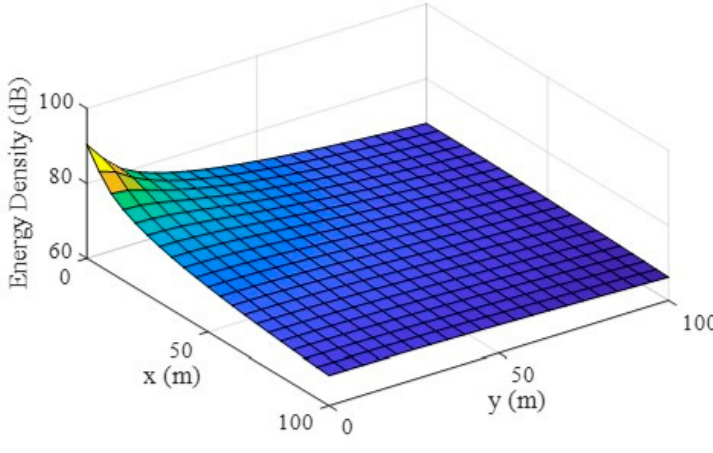
Figure 5. Energy response in space field from the exact displacement solution. The reference energy is 10 − 12 J/m 2 .